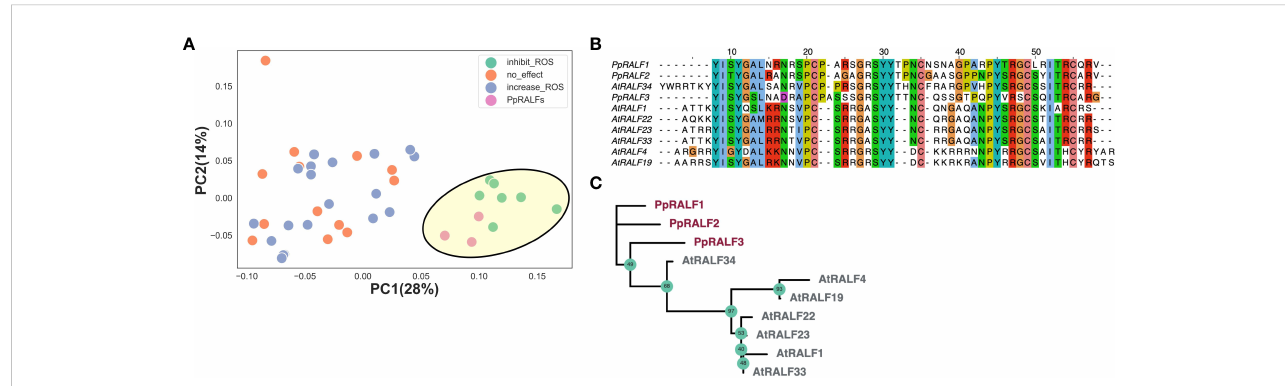
FIGURE 1 (A) Principal Component Analysis (PCA) of amino acid composition, calculated by iFeature tool (Chen et al., 2018) for AtRALF and PpRALF peptides. Moss PpRALFs were clustered with reported immune-related RALF peptides from Arabidopsis, such as AtRALF1, AtRALF4, AtRALF19, AtRALF22, AtRALF23, AtRALF33, and AtRALF34. (B) The multiple pairwise alignment of PpRALFs and immune-related AtRALFs (AtRALF1, AtRALF4, AtRALF19, AtRALF22, AtRALF23, AtRALF33, AtRALF34). (C) An unrooted phylogenetic tree with RALF amino acid sequences from Physcomitrium patens (PpRALF1, PpRALF2, PpRALF3) and immune-related AtRALFs (AtRALF1, AtRALF4, AtRALF19, AtRALF22, AtRALF23, AtRALF33, AtRALF34); Ultra-fast bootstrap (1000 replicates) support values are